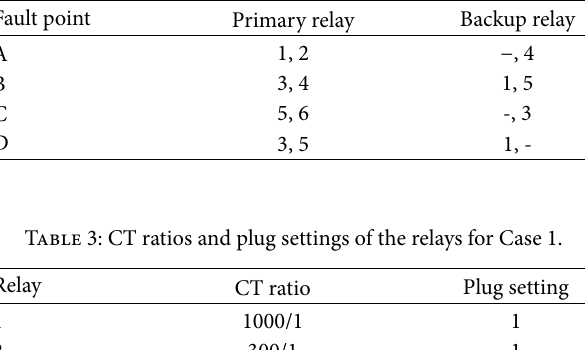
Table 2: Primary and backup relationships of the relays for Case 1.